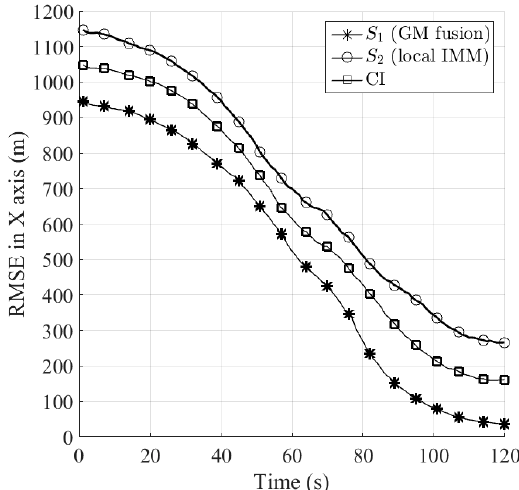
Figure 11. Comparison of RMSE in X axis between the proposed Gaussian mixtures (GM) fusion, local IMM and CI.